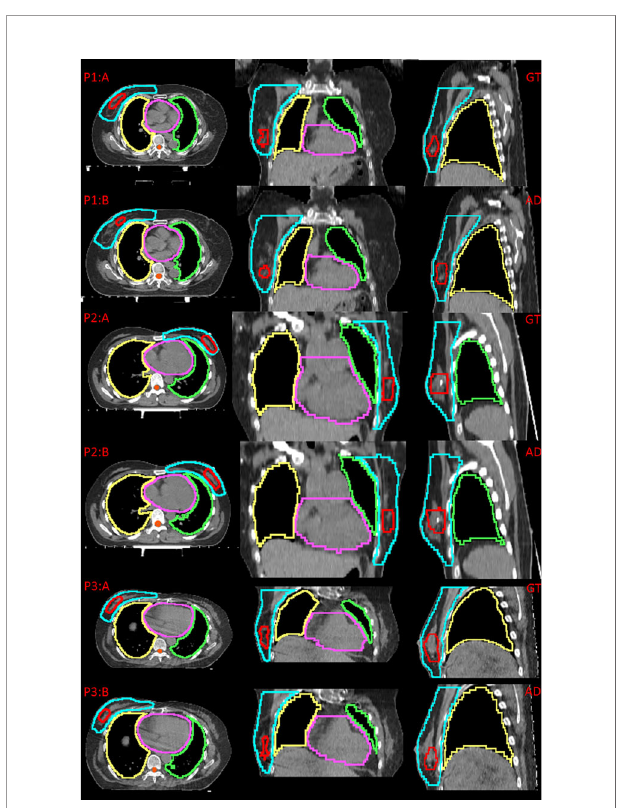
FIGURE 2 | Comparison between the ground truth (GT) and automatic delineation (AD) at axial plane, coronal plane, sagittal plane, P1:A indicates GT on pCT for patient 1, P1:B indicates AD on pCT for patient 1; P2:A indicates GT on pCT for patient 2, P2:B indicates AD on pCT for patient 2; P3:A indicates GT on sCT for patient 3, P3:B indicates AD on sCT for patient